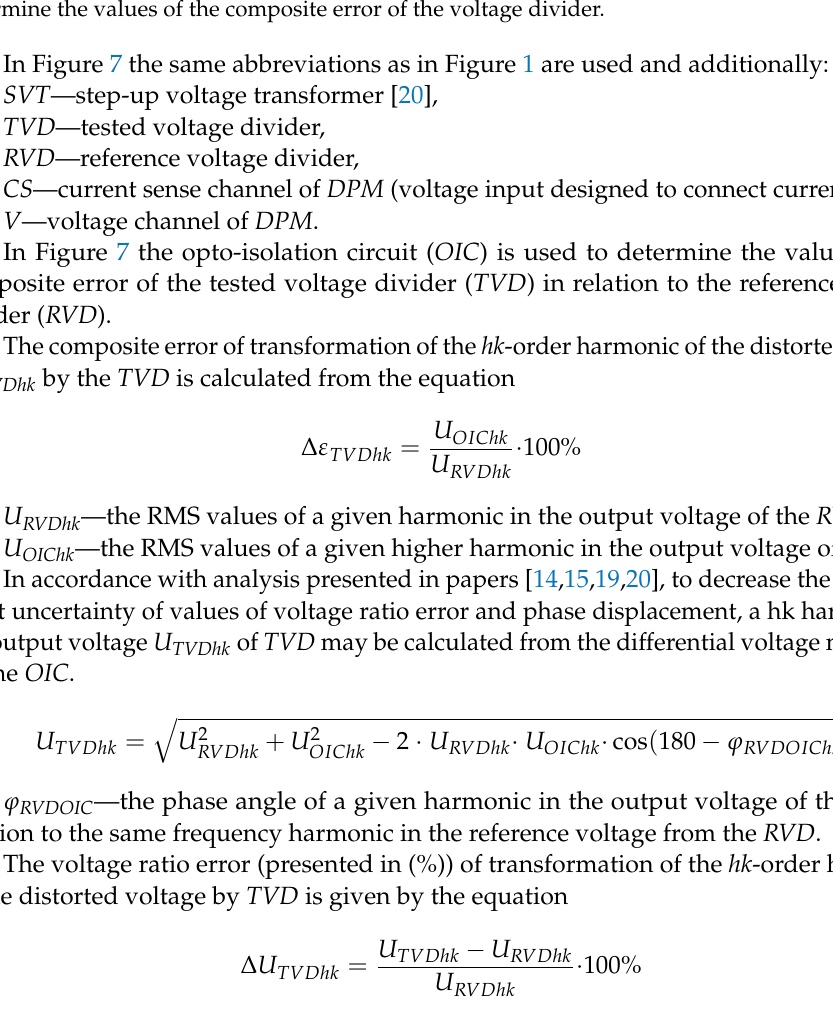
Figure 7. Blocks diagram of the measuring setup for the application of the opto-isolation circuit to determine the values of the composite error of the voltage divider.